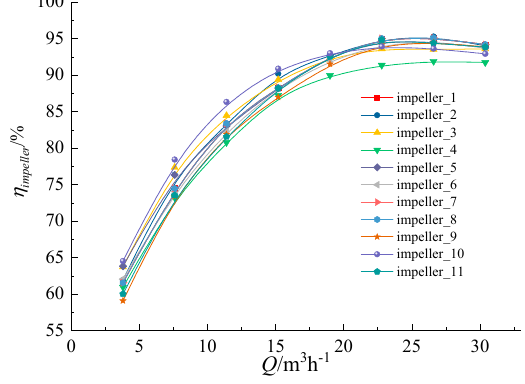
Figure 6. Efficiency curves of impeller under different schemes.